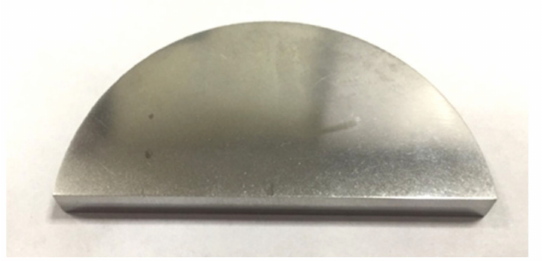
Sample with a metallographic section in the cross-section of the billet for microstructure